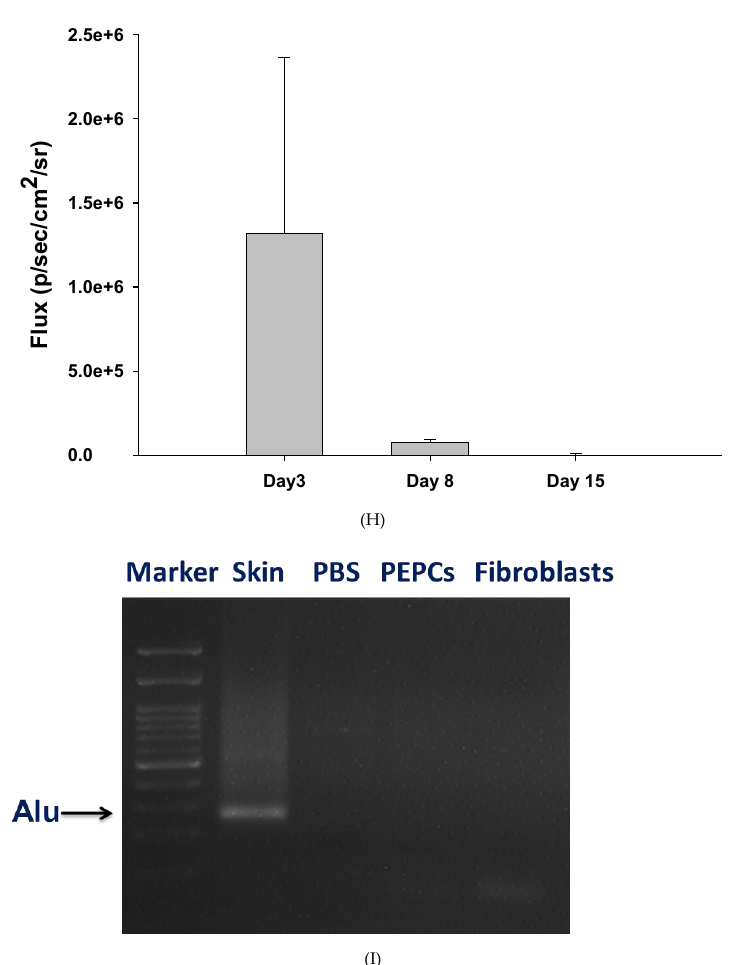
Figure 4. PEPCs restore cardiac functions and initiate tissue regeneration after transplantation into an ischemic heart. ( A ) Long-axis views from an echocardiogram performed 21 days post-infarction showed improvement of cardiac contractility after PEPCs transplantation ( n = 14) compared to fibroblasts ( n = 16) and PBS ( n = 11). ( B ) Left ventricle ejection fractions were improved in mice injected with PEPCs (* p < 0.05). ( C ) Masson trichrome stain of ischemic heart in which viable tissue stains red whereas fibrous tissue stained blue, representative heart 3 weeks after PBS injection ( n = 11); ( D ) fibroblasts transplanted ( n = 10); and ( E ) PEPCs transplanted ( n = 10). ( F ) Percent of infarction area in ischemic heart ( **p < 0.01, *** p < 0.001) 3 weeks after cell transplantation. ( G ) In vivo imaging of PEPCs fate after transplantation. A representative mouse injected with 1 × 10 5 PEPCs